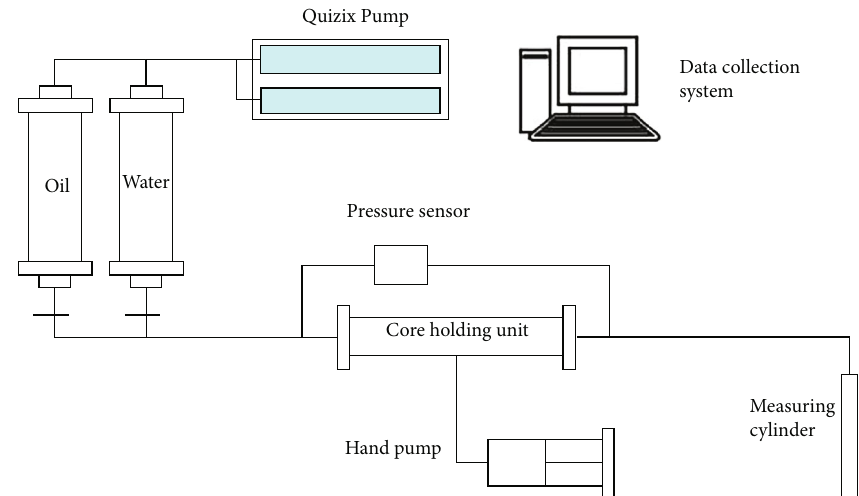
Figure 2: Schematic diagram of two-phase displacement experimental device.